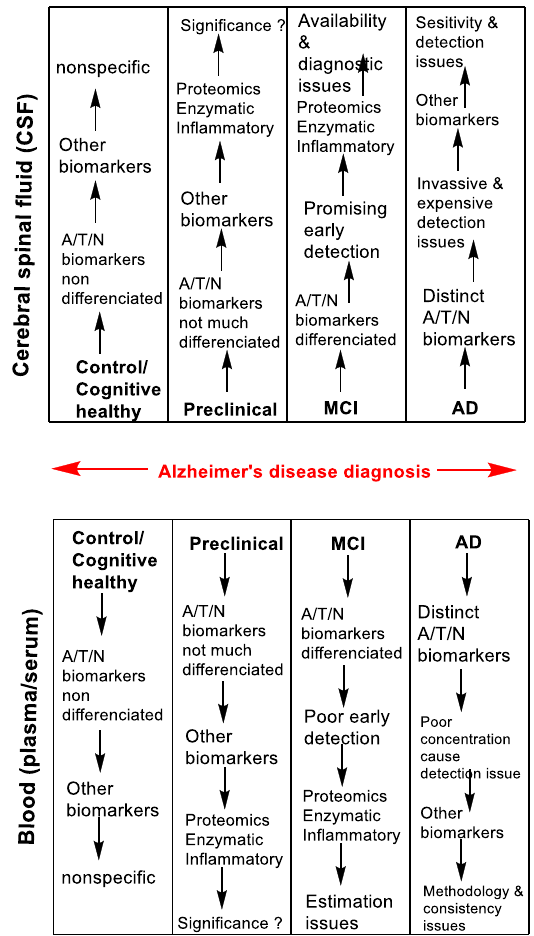
Figure 2. Overview of investigation and development CSF and blood-based biomarkers in Alzheimer’s disease diagnosis.